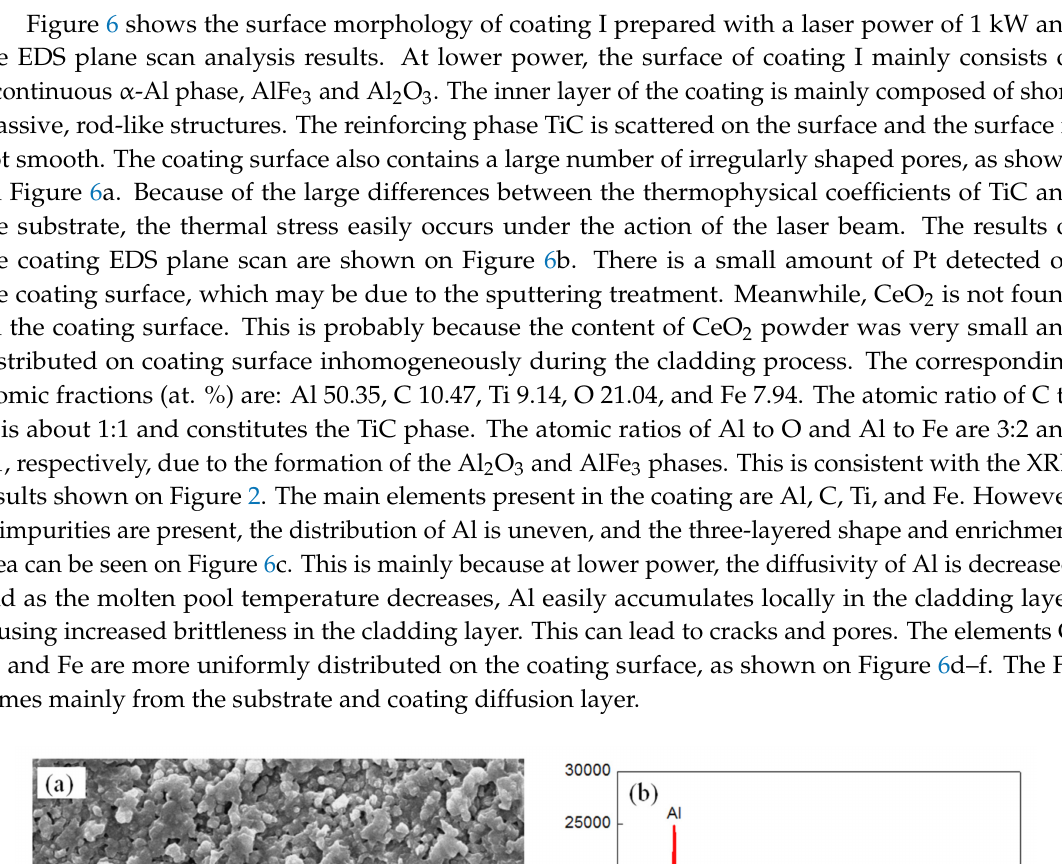
Figure 5. The surface geometry of the coatings: ( a ) Coating I; ( b ) Coating II; ( c ) Coating III; ( d ) Coating IV.